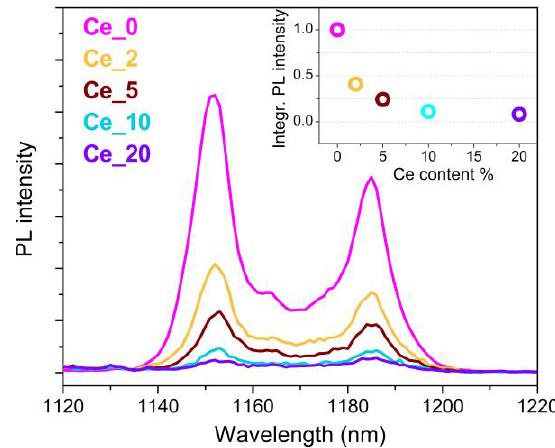
Figure 5. Ho 3+ 5 I 6 → 5 I 8 PL spectra under 980 nm excitation of the Ln 3+ -doped NaBiF 4 samples with different Ce 3+ content. In the inset, trend of integrated PL intensity vs. Ce 3+ content, with signals normalized to Ce_0 sample.